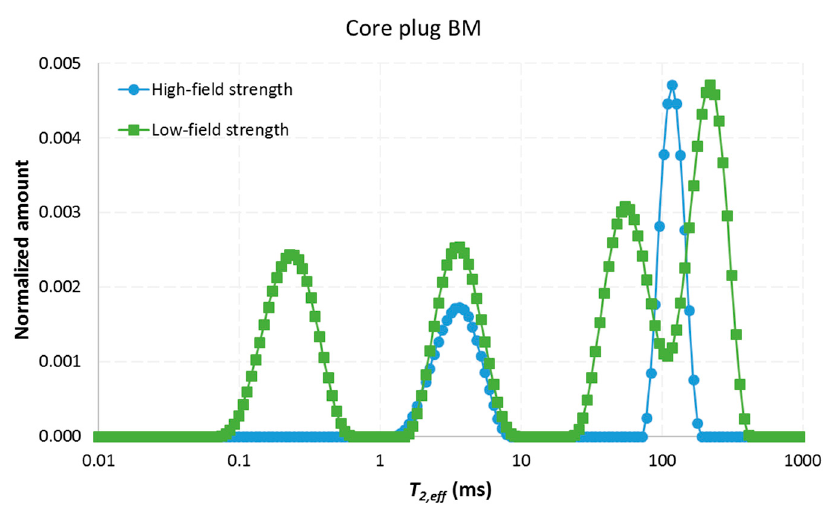
Figure 9. Transverse relaxation distribution for core plug BM obtained by the CPMG sequence at high-field strength, B 0 = 4.70 T, and low-field strength, B 0 = 0.28 T. The low-field distribution is normalized with respect to the bulk water distribution, and the sum of the data points is a measure of the porosity of the core plug. The high-field distribution is scaled to the amplitude of the low-field distribution.